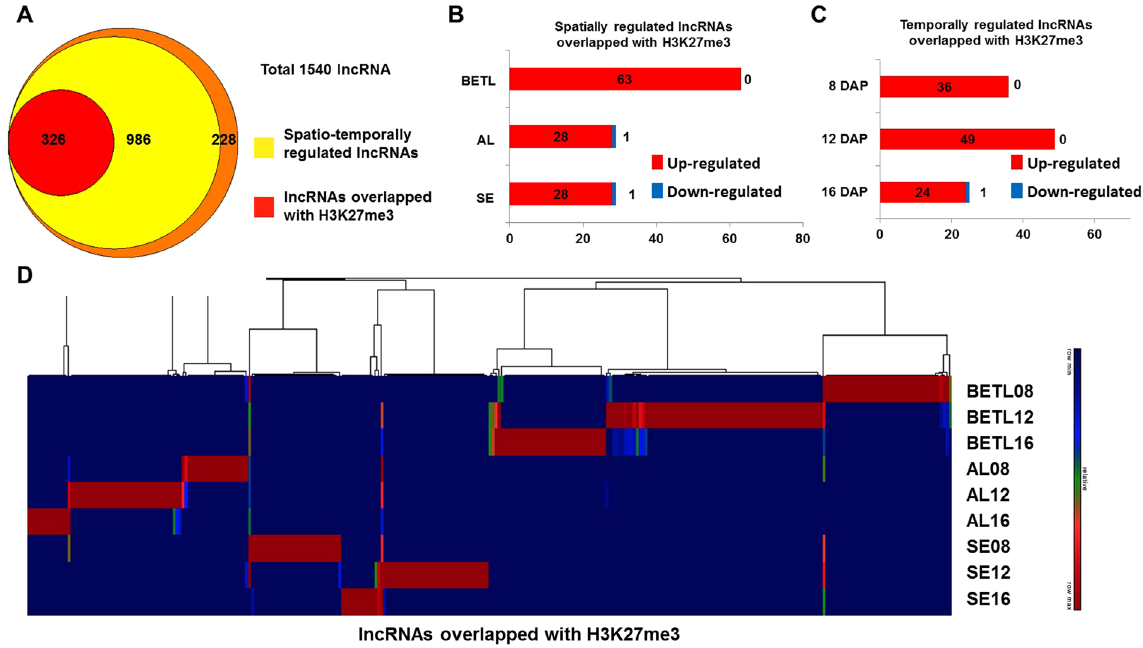
Figure 4. Spatio-temporally regulated lncRNA loci overlap with H3K27me3-marked loci. ( A ) Venn diagram representing the overlap between H3K27me3-enriched loci and spatio-temporally regulated lncRNA transcription sites. ( B ) The numbers of lncRNAs that overlap with H3K27me3 enriched loci that are up- or down-regulated more than 4-fold at any tissue are shown. (C) The numbers of lncRNAs that overlap with H3K27me3-enriched loci that were up- or down-regulated more than 4 fold at any DAP are shown. ( D ) Hierarchical cluster analysis of spatio-temporally regulated lncRNAs that overlap with H3K27me3-enriched